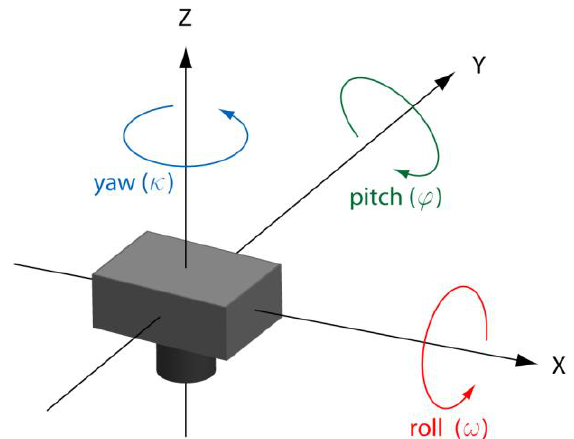
Figure 1. Three axes and rotations of a digital still